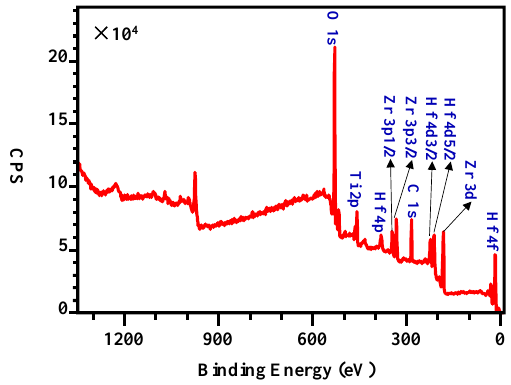
Figure 6. The XPS survey scan of the Ti-Zr-V-Hf film at 25 °C.